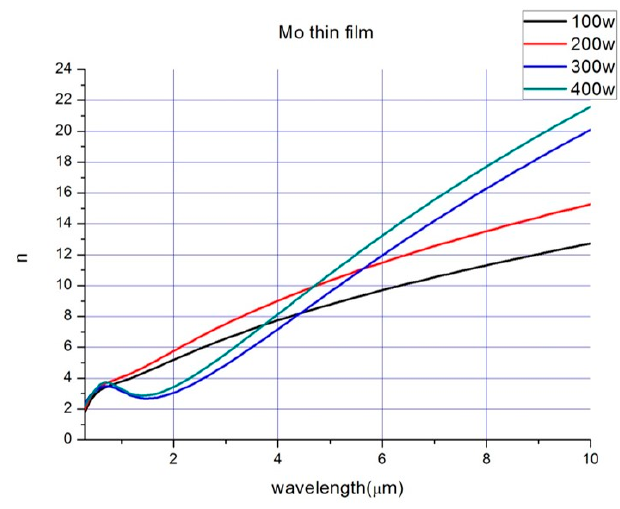
Figure 8. The refractive index of the Mo absorption layer for different deposition powers.